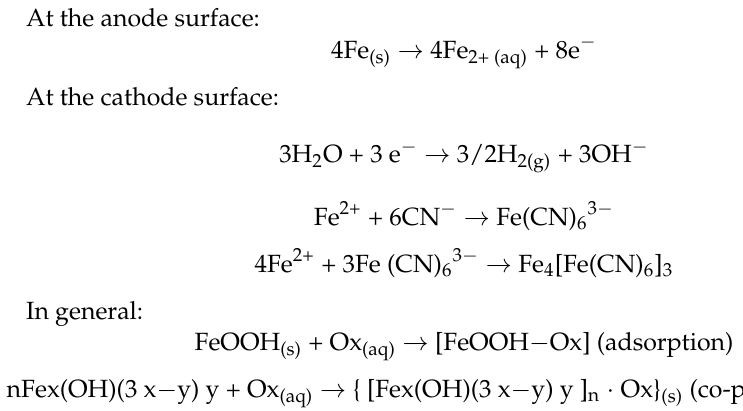
Figure 7. Removal of pollutions by (PEC) M using Fe-Al and Fe-SS.